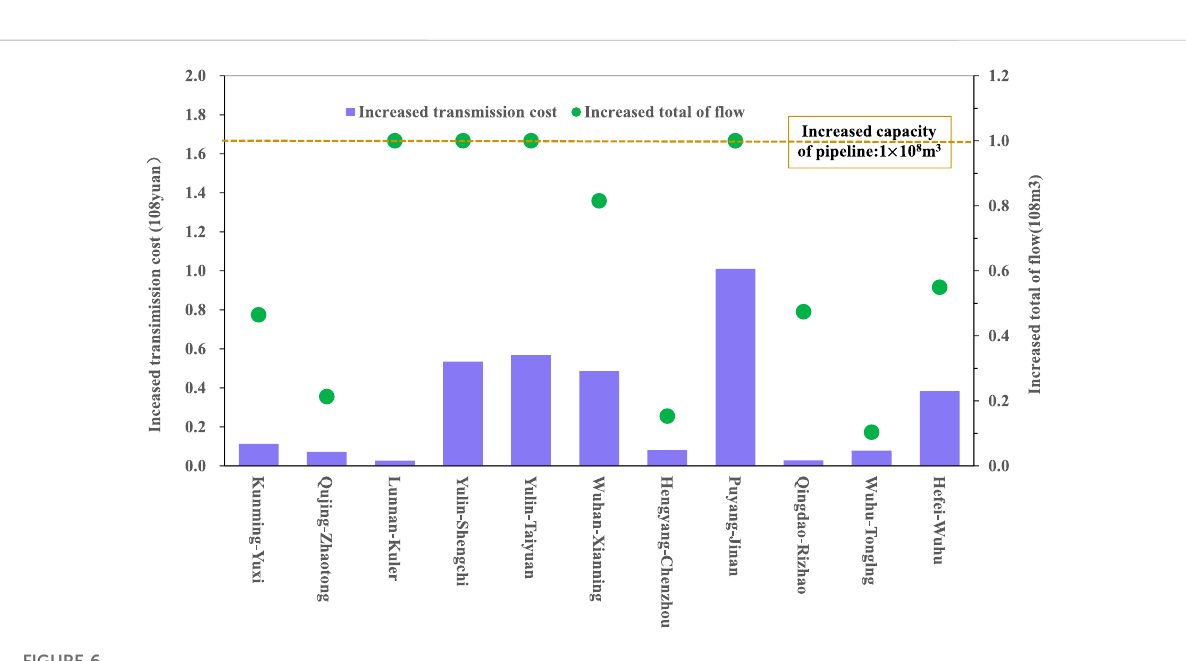
FIGURE 6 Impact of pipe capacity changes on the marginal cost and marginal fl ow of distribution